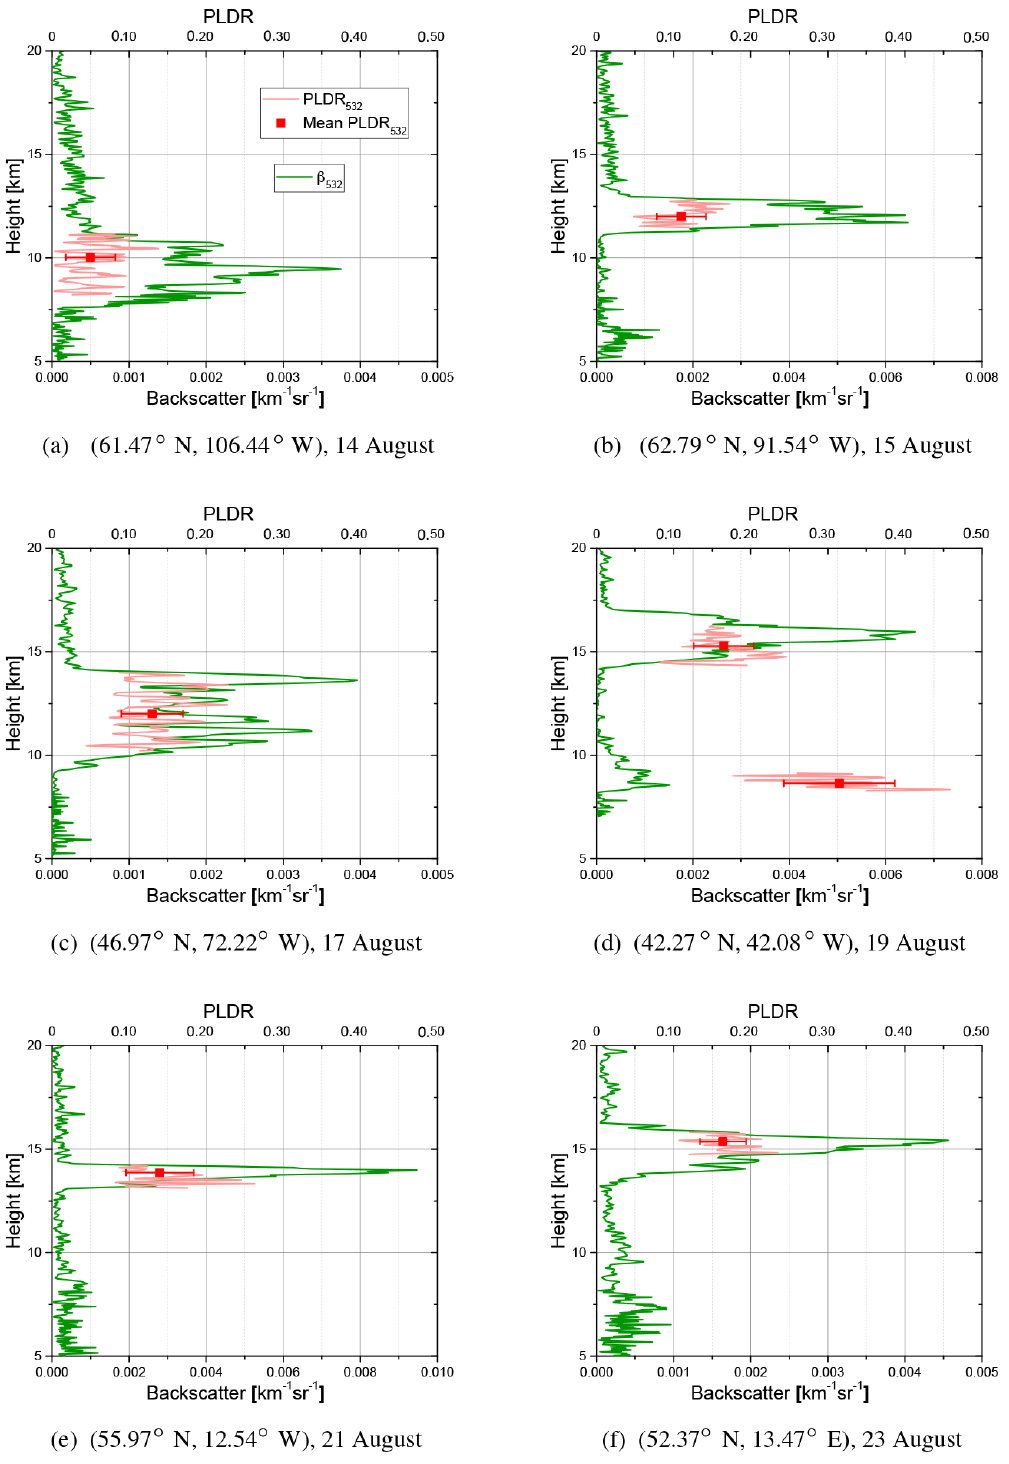
Figure 7. The profiles of backscatter coefficient and particle linear depolarization ratio (PLDR) at 532nm from CALIPSO. Panels (a) – (f) correspond to the six locations (a) – (f) in Fig. 4. The corresponding CALIPSO tracks are (a) 09:50:19, 14 August 2017; (b) 08:54:37, 15 August 2017; (c) 07:03:13, 17 August 2017; (d) 06:50:44, 19 August 2017; (e) 03:20:25, 21 August 2017; and (f) 01:29:01, 23 Au- gust 2017. A total of 20 profiles are averaged over these six locations. The solid green and pink lines represent backscatter coefficient and particle linear depolarization ratio, respectively. The red squares with error bars represent the mean particle linear depolarization ratio and the standard deviation within each